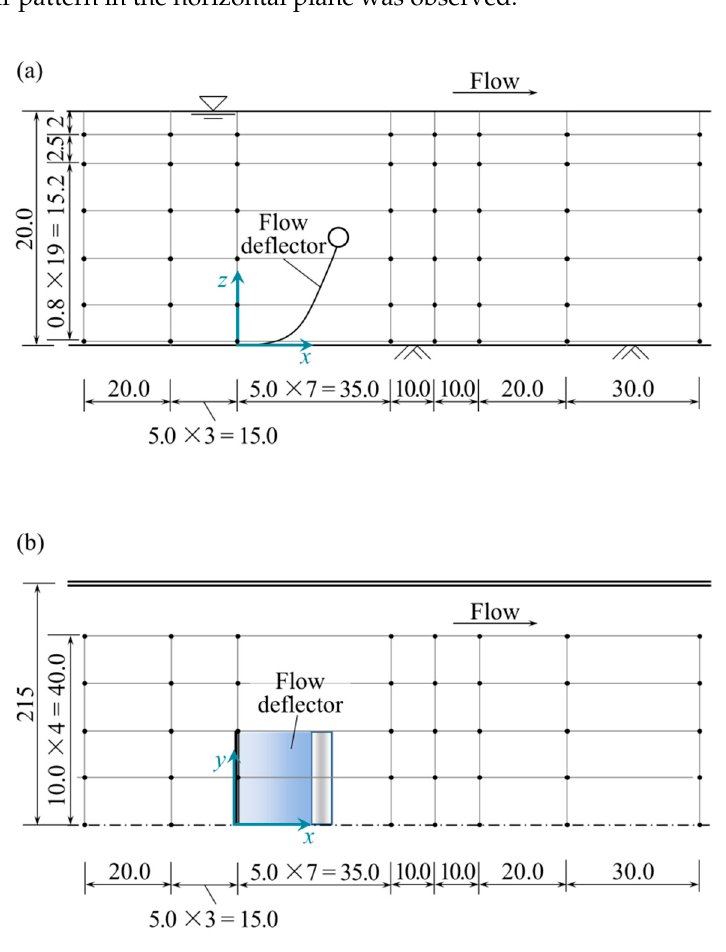
Figure 4. Measuring points near a flexible flow deflector (not to scale, unit: cm): ( a ) Side view, ( b ) Top view.